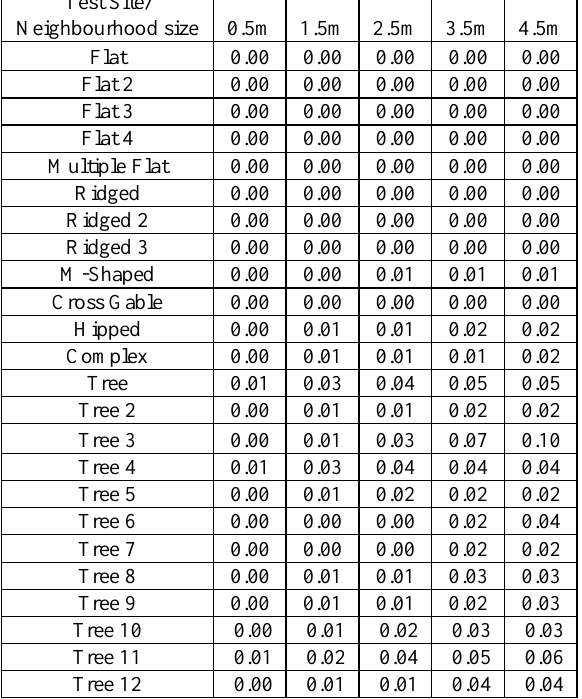
Table 2. Median Curvature (m) for test sites of different neighbourhood sizes for buildings and trees. The results of the roughness tests, as presented in Table 3, exhibit a greater difference between trees and buildings at various neighbourhood sizes. For all test sites median roughness increases as the neighbourhood increases with simpler roof types having a small median roughness compared to